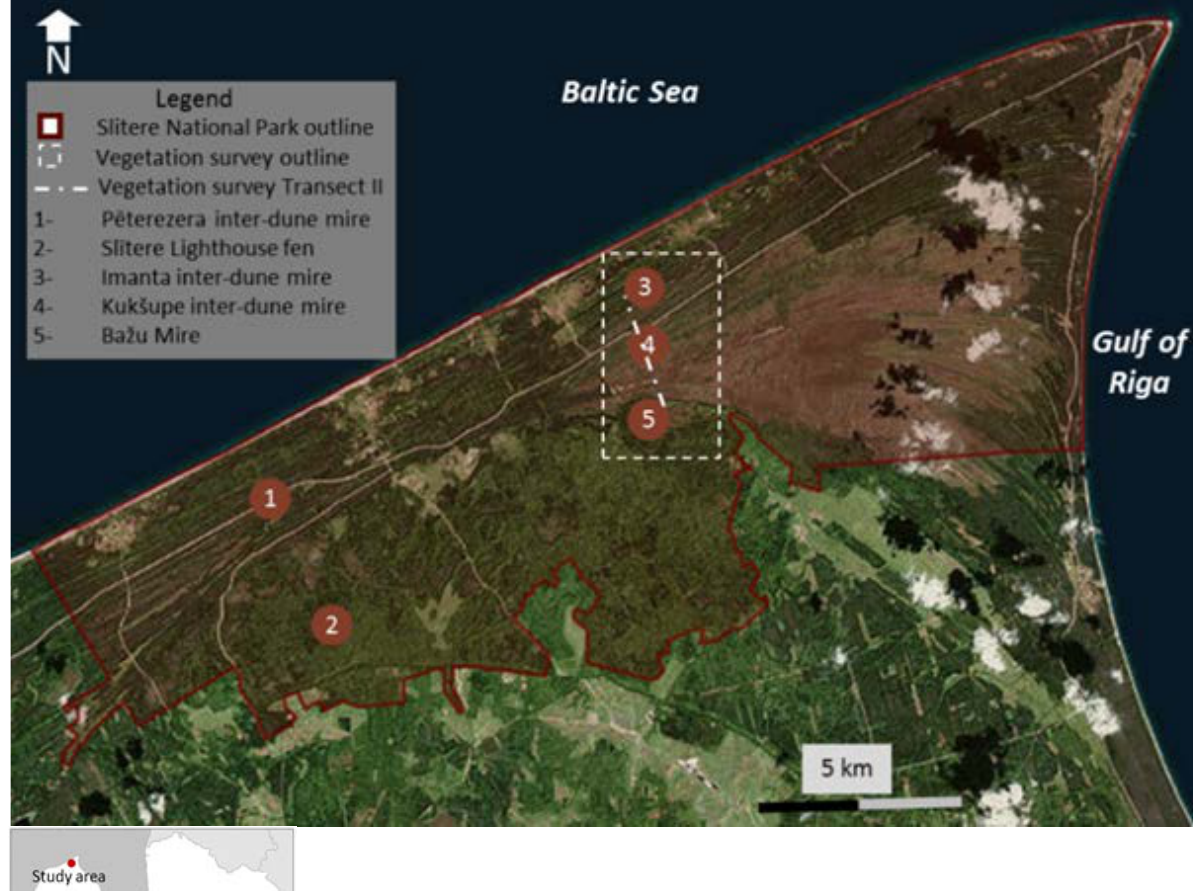
Figure 1. Study area land cover and distribution of study sites in Slitere National Park (adapted from Wolejko et al . 2019). Map source: GIS_Lat vija10.2., LiDAR DEM, LU ĢZZF